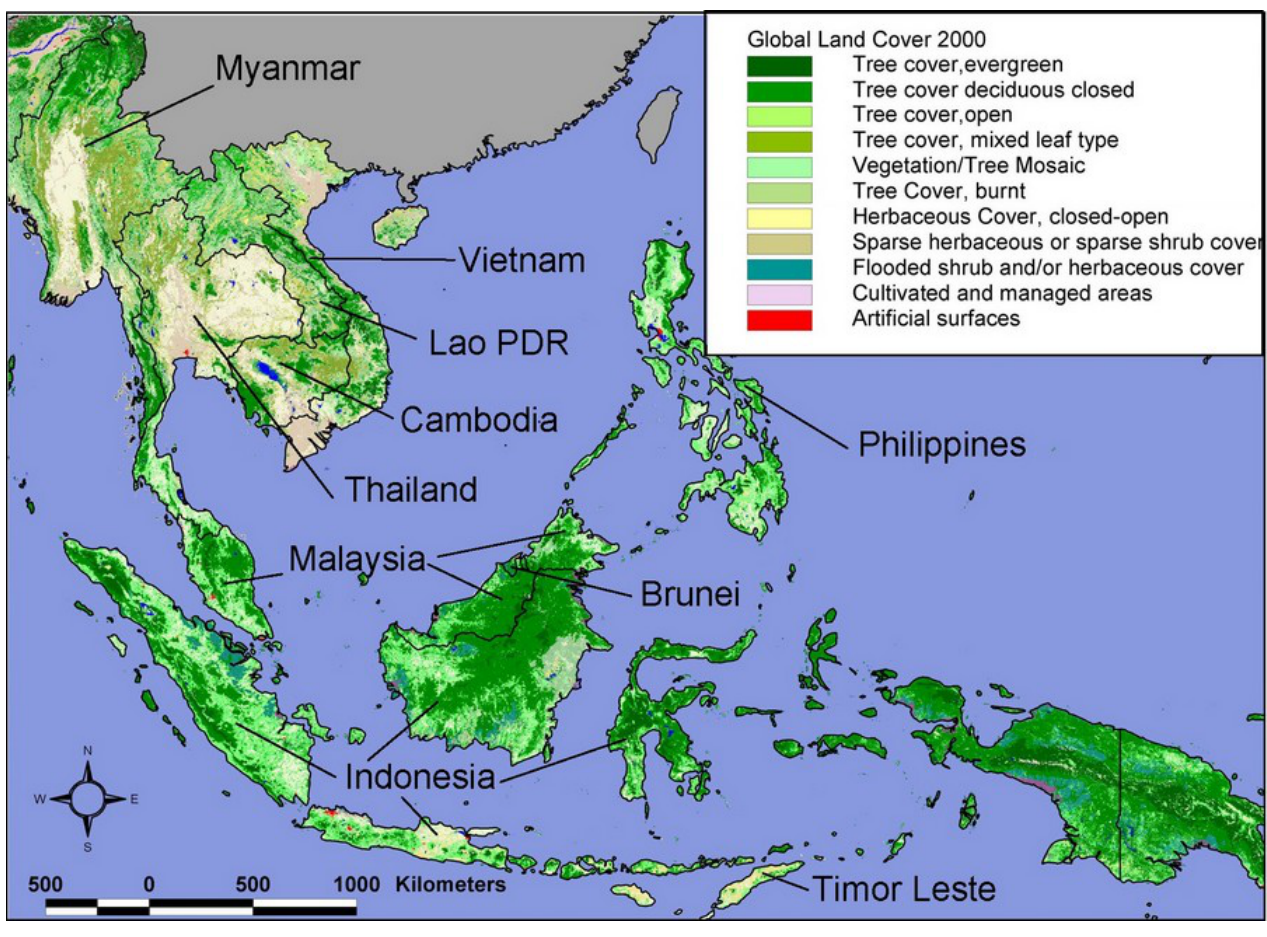
Fig. 1. Land cover map for Southeast Asia in 2000. Source: Stibig et al.